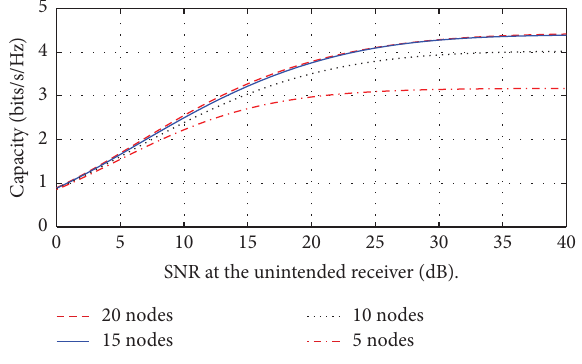
Figure 17: Capacity comparison: average outcome.